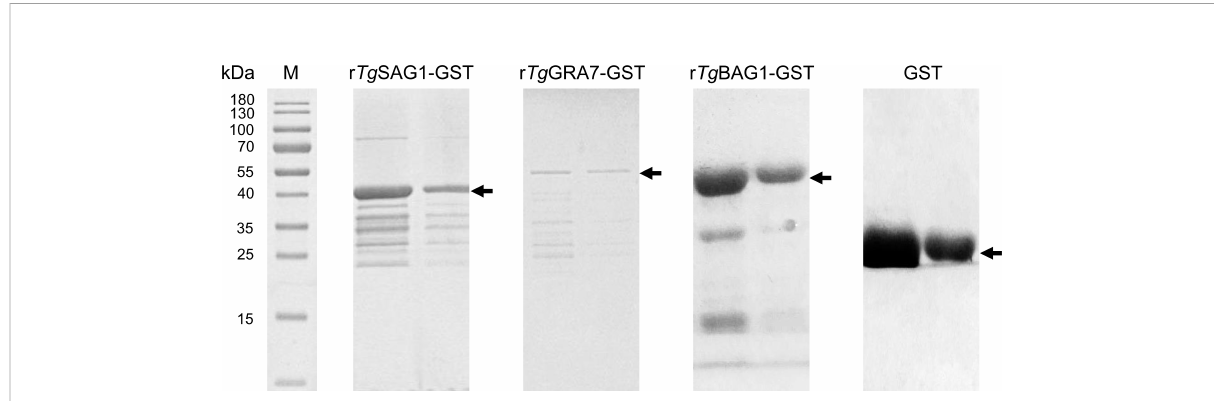
FIGURE 1 The recombinant SAG1, GRA7 and BAG1 proteins of T. gondii was expressed. SDS-PAGE analysis showed the rSAG1, rGRA7, rBAG1 and GST